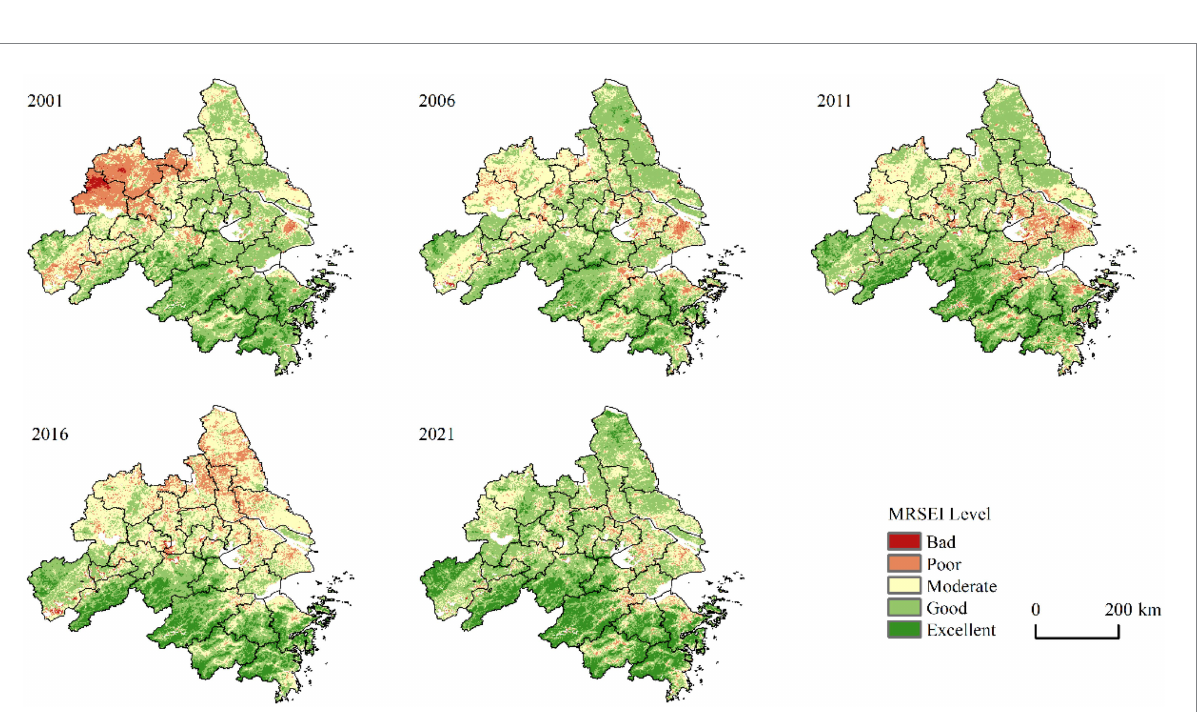
FIGURE 5 Spatial distribution of ecological environment quality levels in study area from 2001 to 2021.